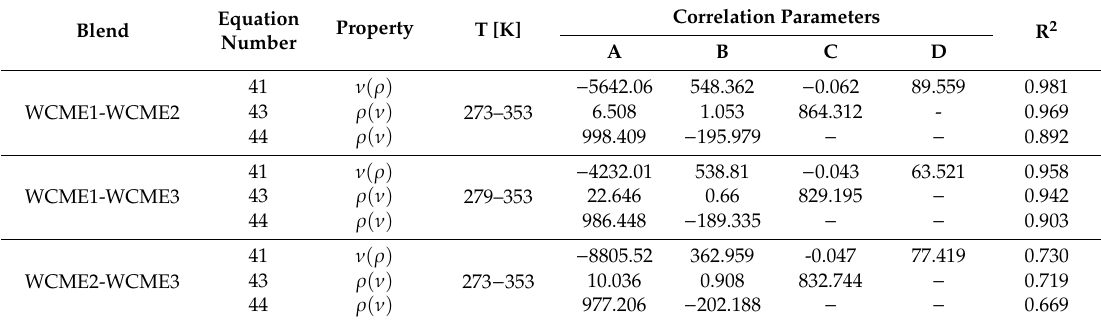
Table 11. Viscosity-density correlations for biodiesel blends; correlation parameters and R 2